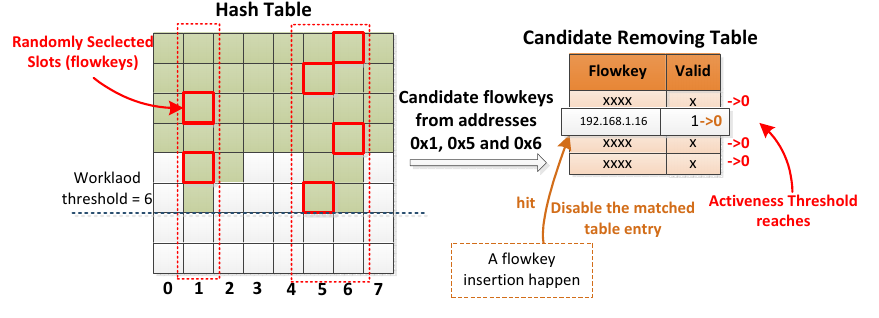
Figure 8. Procedure of flowkey